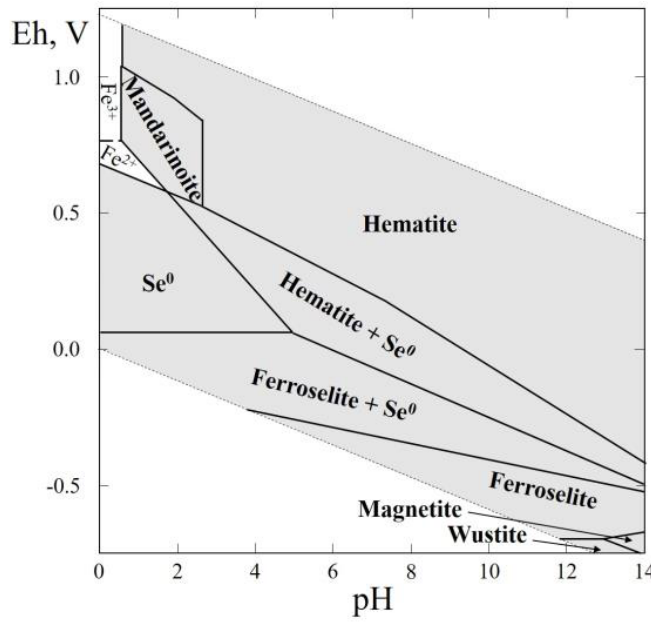
Figure 4. Eh – pH diagram of the OHSeFe (Fe – Se – H 2 O) system at 25 °C and the activities of the components: a Σ Se = 10 − 4 , a Σ Fe = 10 − 2 . The dotted line is the boundary between fields of Fe 2+ and Fe 3+ .